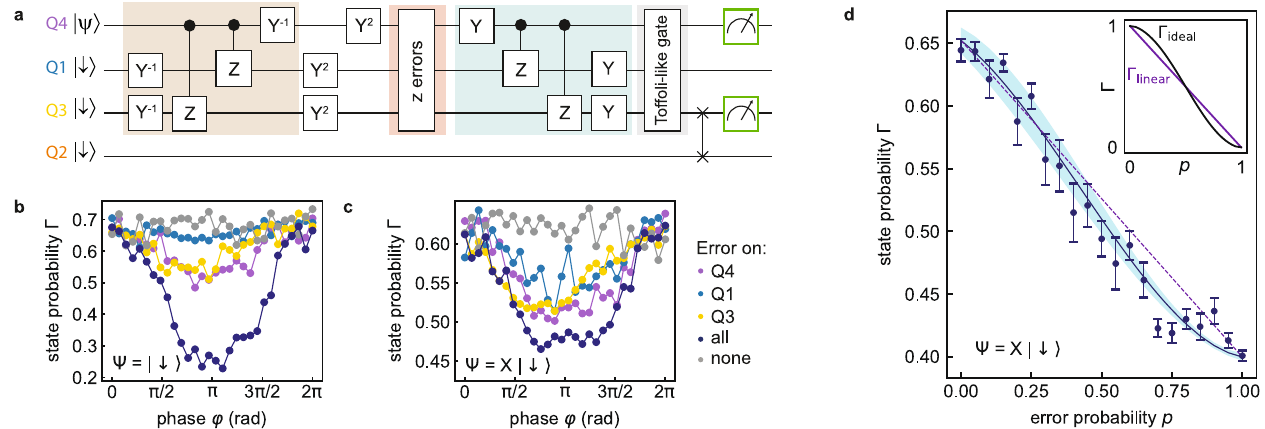
Fig. 4 Three-qubit phase fl ip code. a Implementation of the three-qubit phase fl ip code. Q4 serves as data qubit, Q1 and Q3 as ancilla qubits, and Q2 as reset qubit for Q3. The correction step is implemented with the Toffoli-like gate as shown in Fig. 3e. The data qubit is read out with readout system Q3Q4, which makes it necessary to reset Q3 using a resonant SWAP operation with Q2. b , c Results of the phase fl ip code while introducing a phase error Z( φ ) on none of the qubits (gray), on Q4 (purple), Q1 (blue) or Q3 (yellow) or on all three qubits simultaneously (dark blue). The initial state of the data qubit is #j i in b and X #j i in c . d Phase fl ip code with introducing phase errors Z( φ = π ) with probability p . The data qubit is prepared to the state X #j i and through single-qubit gates projected to the #j i state for readout. Plotted is the state probability ( Γ ), the error bars indicate the standard deviation. The results are fi tted using a model which takes into account the readout and reset errors (see Supplementary Discussion 4). The standard deviation of the fi t is indicated by the light blue area. The inset shows the curve for ideal phase fl ip correction ( Γ ideal ) and the linear line for no phase fl ip correction ( Γ linear